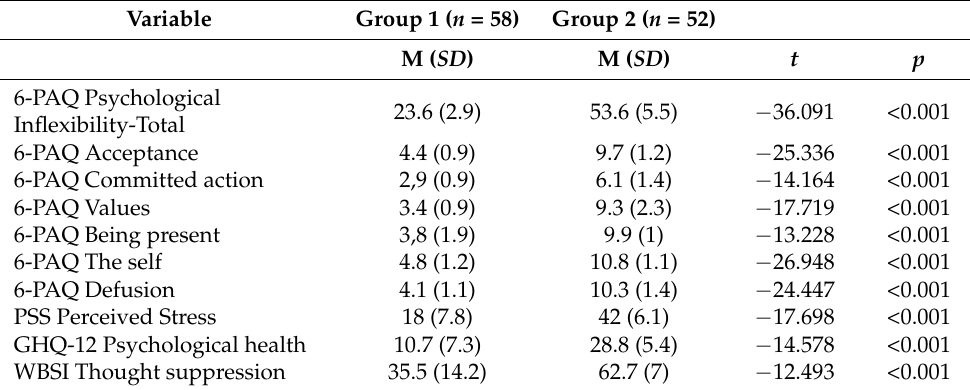
Table 2. Differences between groups based on levels of psychological flexibility.